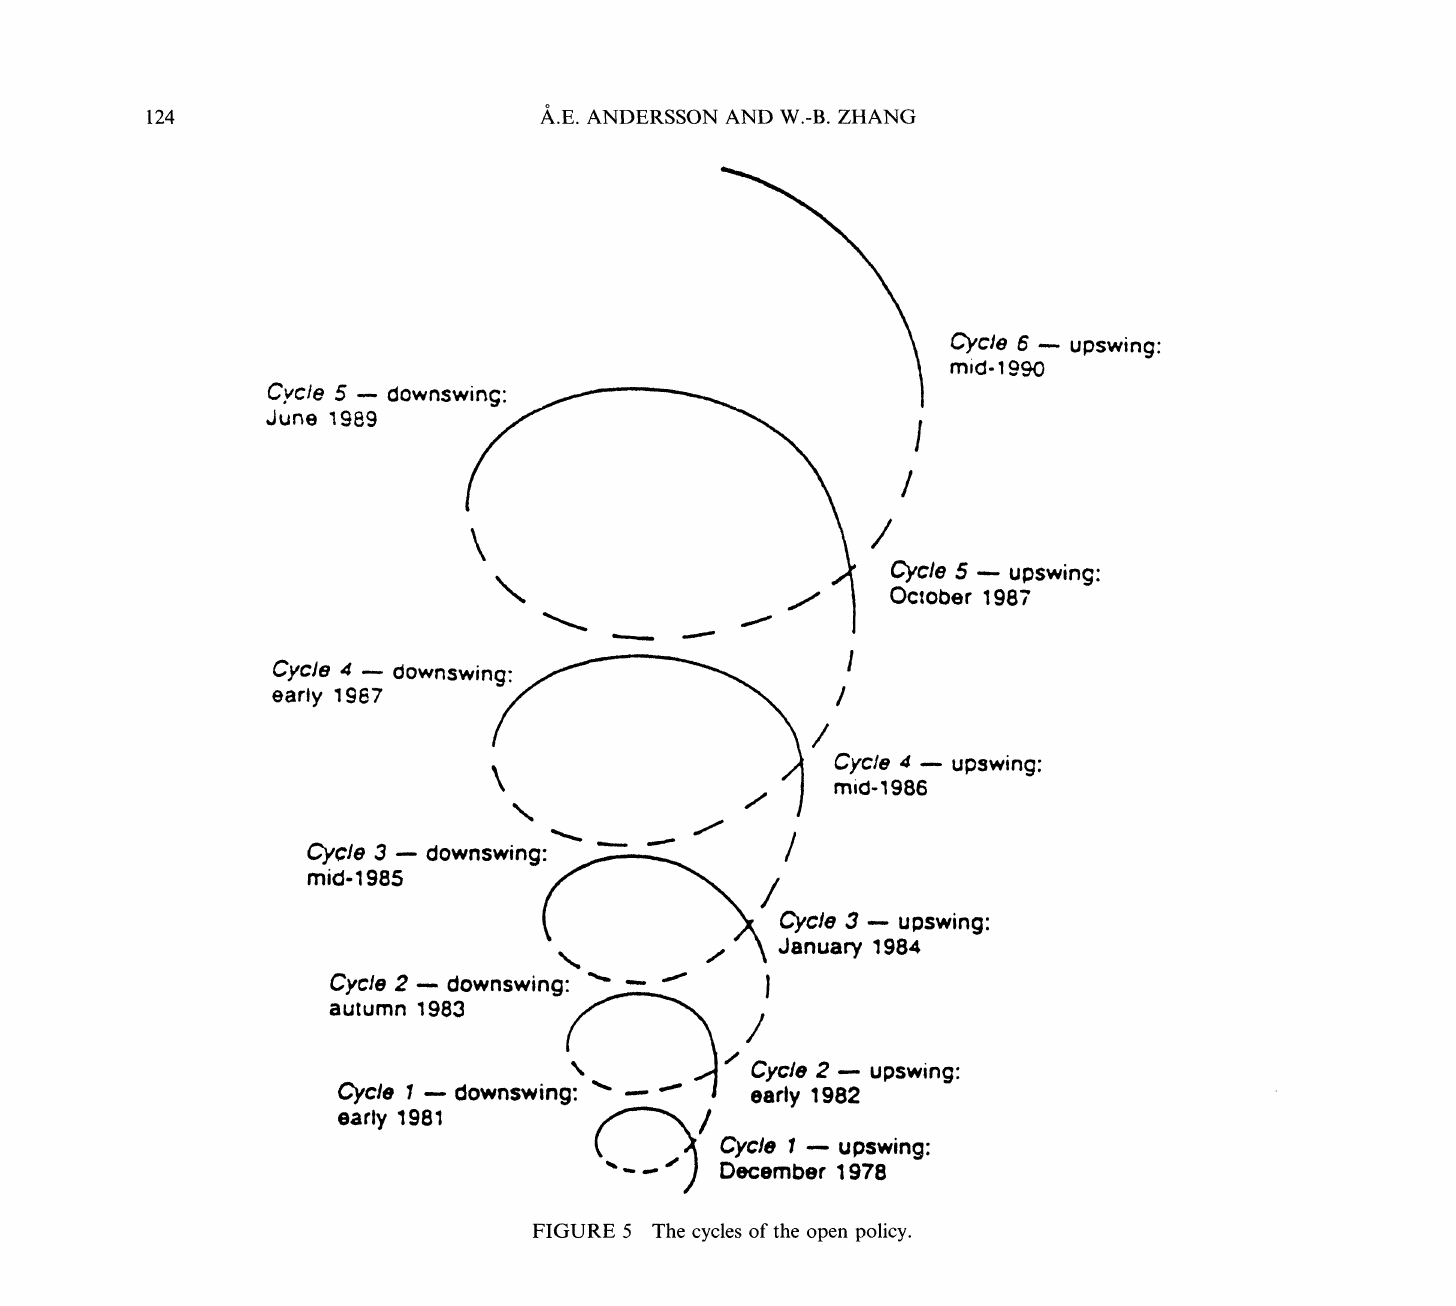
FIGURE 5 The cycles of the open